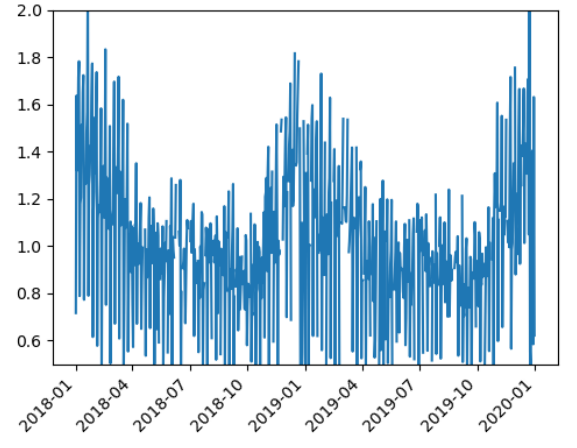
Figure 8. Aggregated occupancy ratio R agg between 2018-01-01 and 2019-12-31, estimated with the C/SimpleT method. A value of 1.0 means that the occupancy ratio was about the same as a median day. A value of 2.0 means it was double than a median